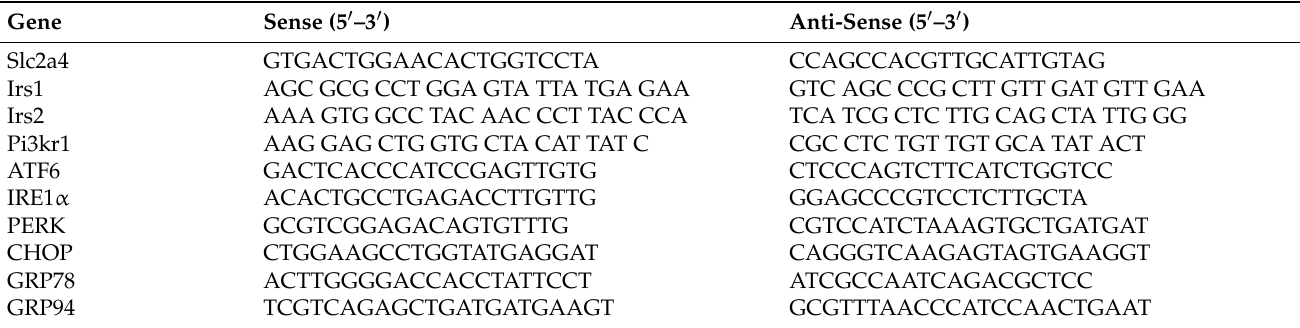
Table 1. Sequences of primers for